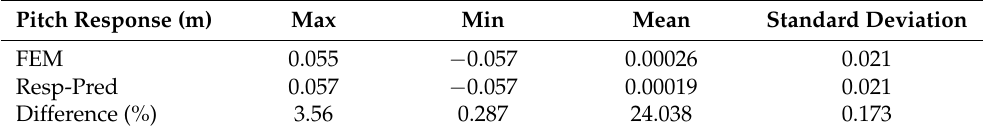
Table 5. ANN and FEM statistical pitch responses for wave height of 9.65 m and the wave period of 9.94 s. Pitch Response